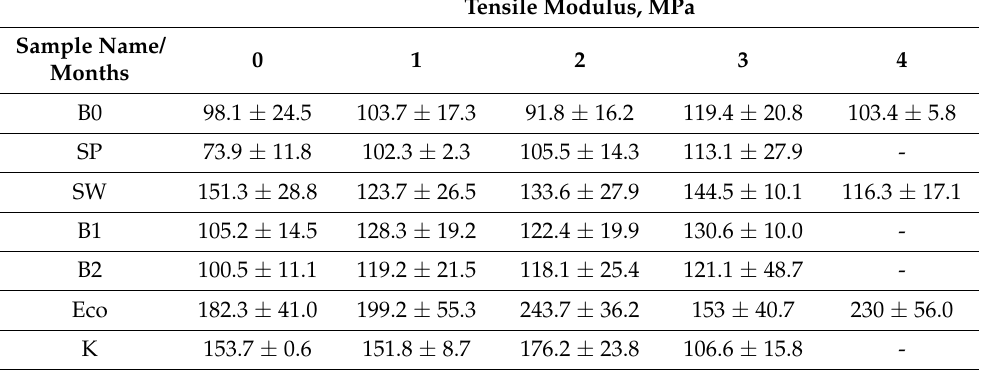
Table 5. Tensile